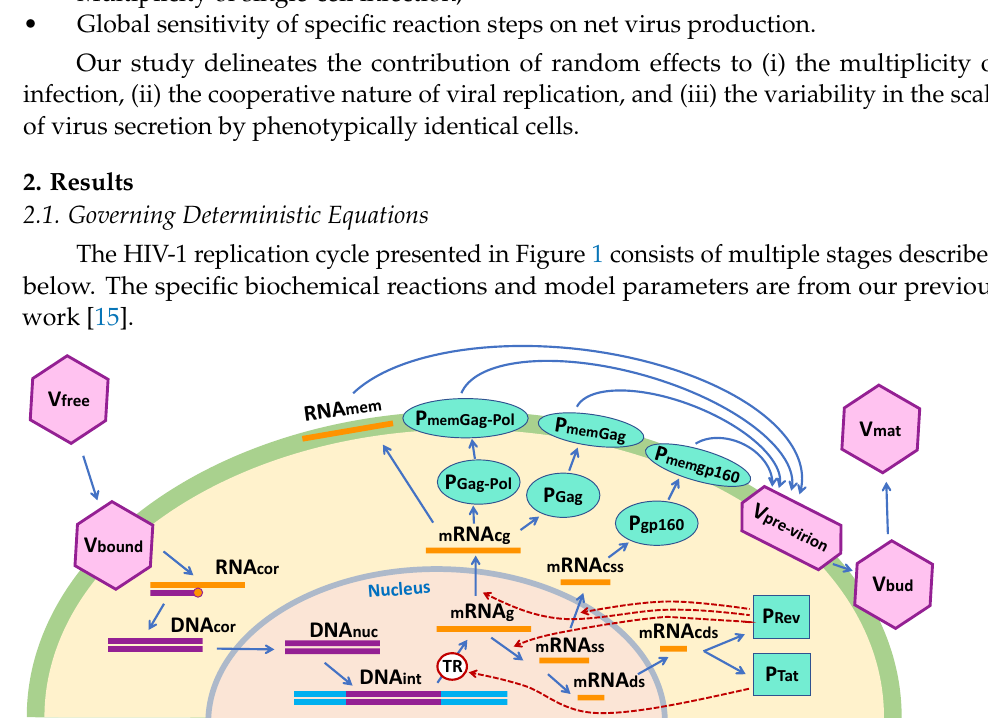
Figure 1. Biochemical scheme of the HIV-1 replication